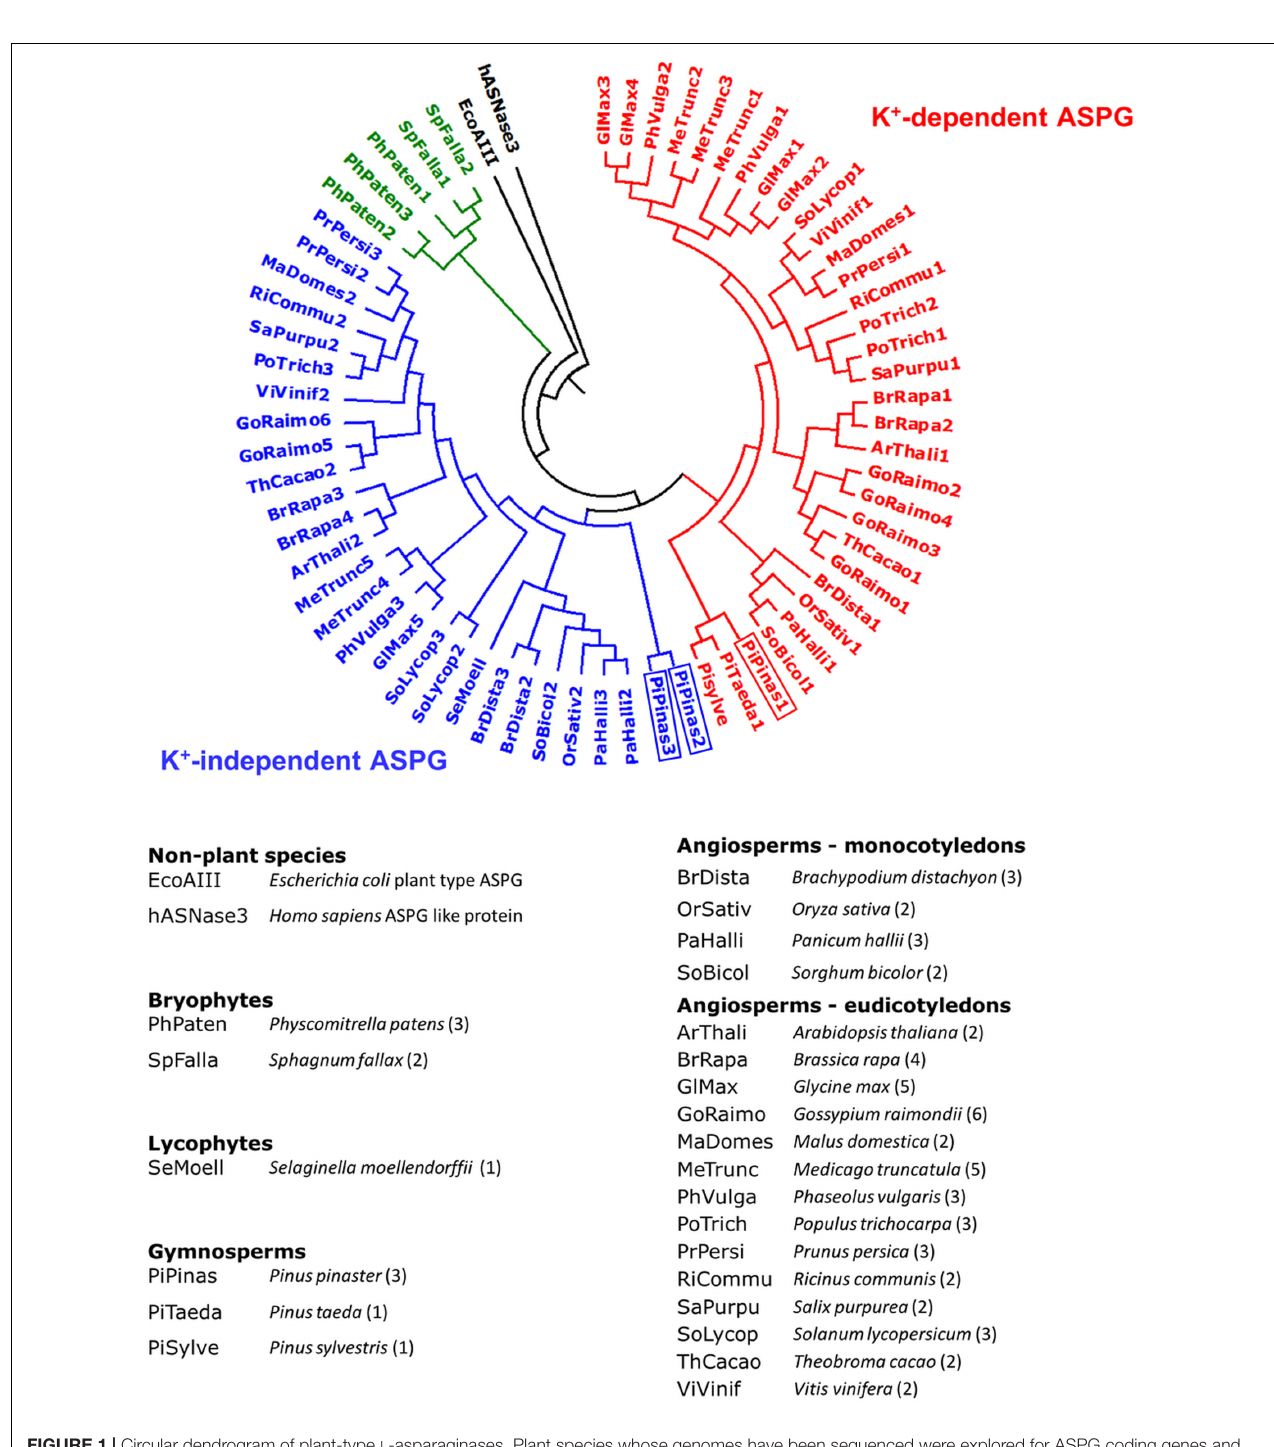
Frontiers in Plant Science |